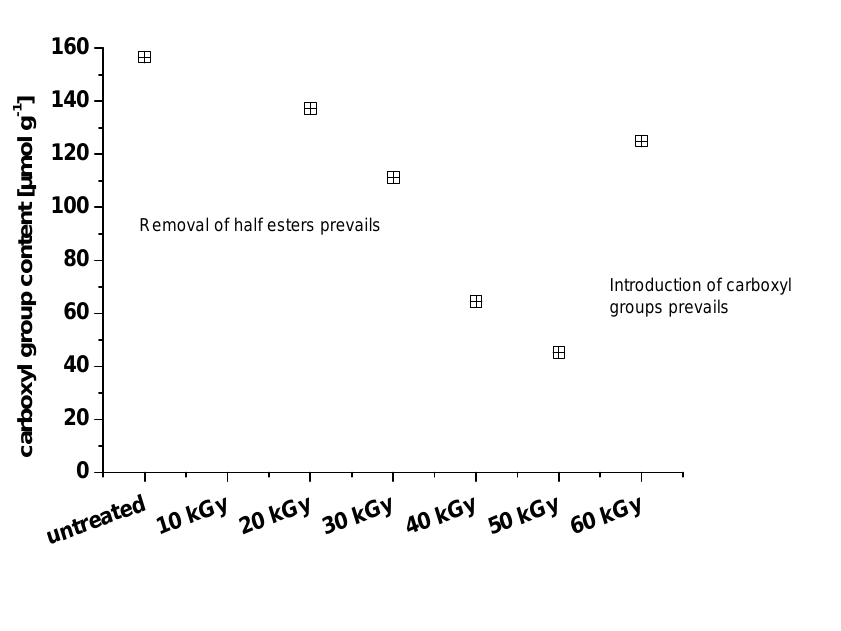
Figure 6. Changes in carboxyl groups of nanocrystalline cellulose upon increasing irradiation